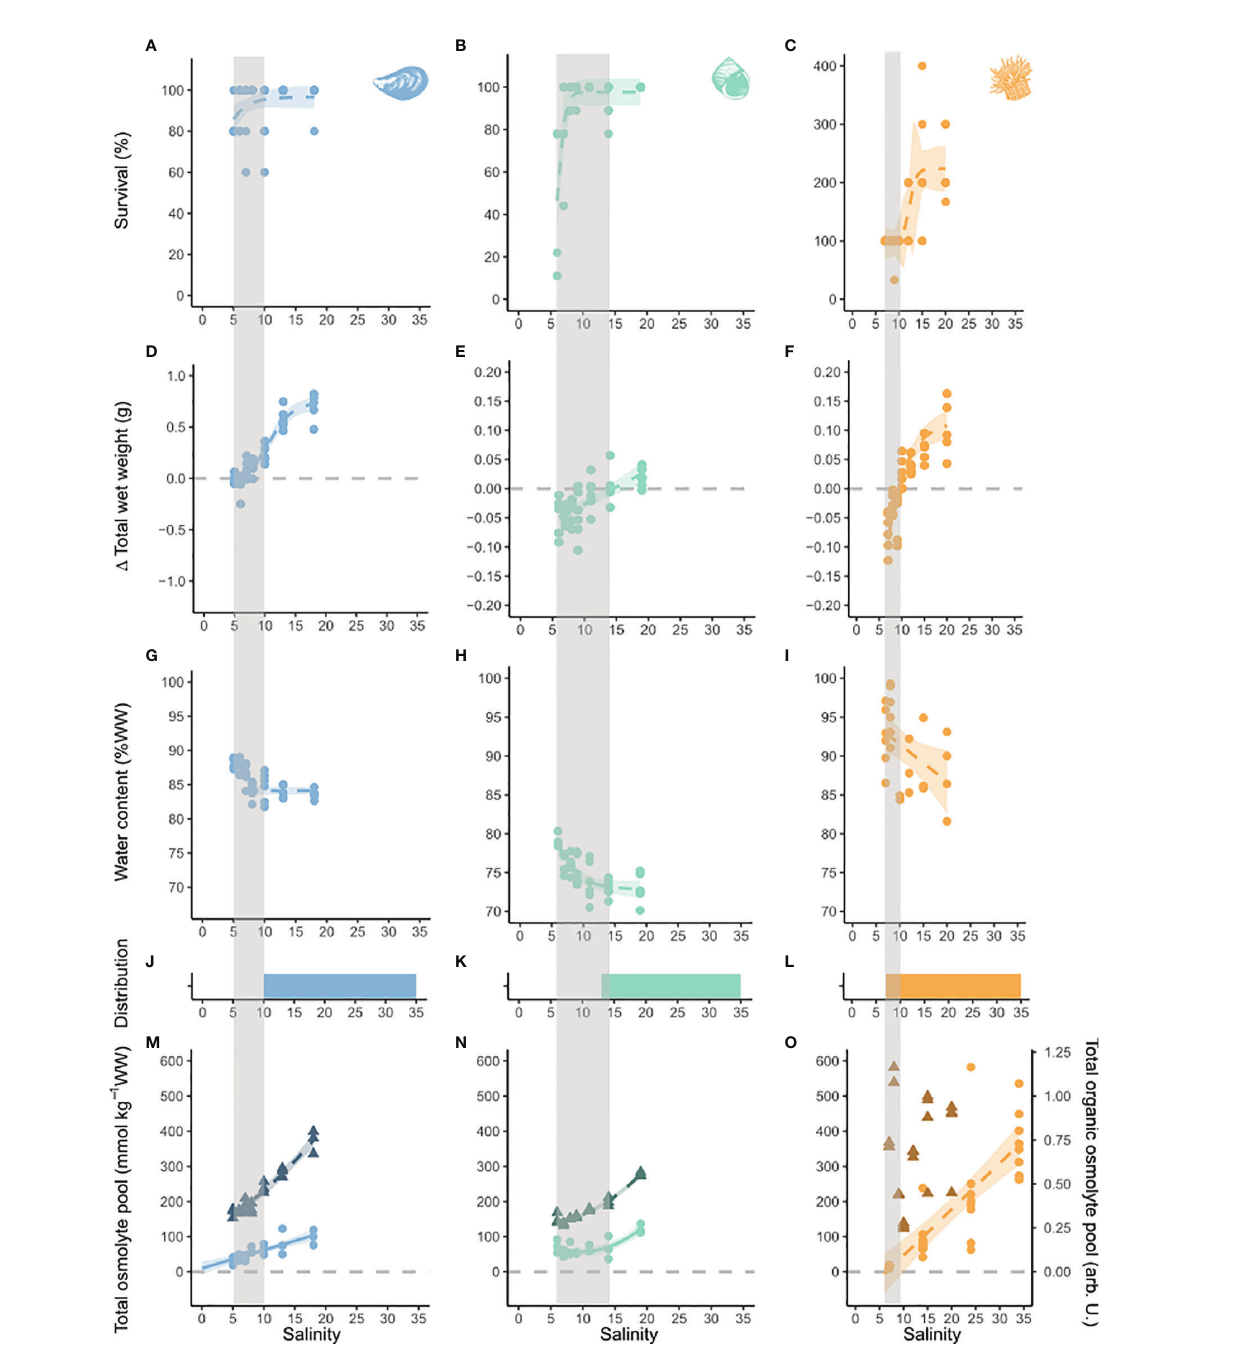
FIGURE 1 | Effect of long-term low-salinity acclimation on survival, growth, water content, distribution and osmolyte pool size on blue mussels, common periwinkles and orange-striped anemones. Salinity is depicted on the x-axis. On the y-axis survival is presented in %, (A – C) change in total wet weight in g, (D – F) water content in % wet (G – I) weight and osmolyte pools in mmol per kg wet weight. (M – O) Osmolyte pools were corrected for relative weight change due to increase in water content with decreasing salinity. The inorganic pool is depicted by triangles and the organic pool by circles. No organic osmolytes were measured for orange-striped anemones, instead osmolyte data from a previous study is shown (Podbielski et al., 2016). Colored bars represent the species ’ known salinity range in the Baltic Sea. (J – L) Models were fi tted to raw data points for seven treatment levels. If no model is shown, there was no signi fi cant model. Models were chosen according to best fi t. Model outcomes are listed in Table S4 . Shaded areas represent a 95% con fi dence interval. Four treatment levels were clustered around the lower salinity threshold of each species, two levels represented intermediate salinity and the highest one was close to control conditions. Species are marked by color code and symbol: blue - blue mussels ( Mytilus sp.), turquoise - common periwinkles ( Littorina littorea ), orange - orange-striped anemones ( Diadumene lineata ). Grey vertical bars represent the critical salinity range derived from the salinity thresholds of the complementing measurements of physiological and biochemical